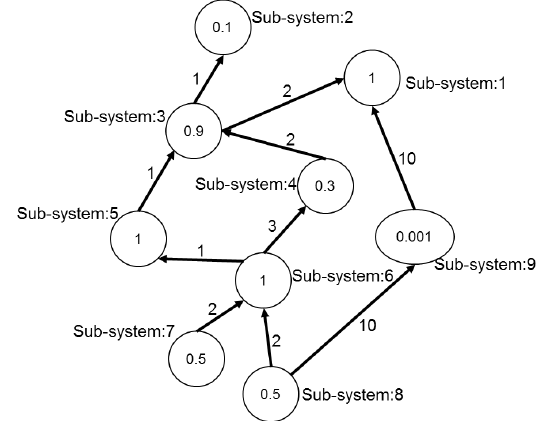
Figure 2. A Sample Network for Calculating Flow